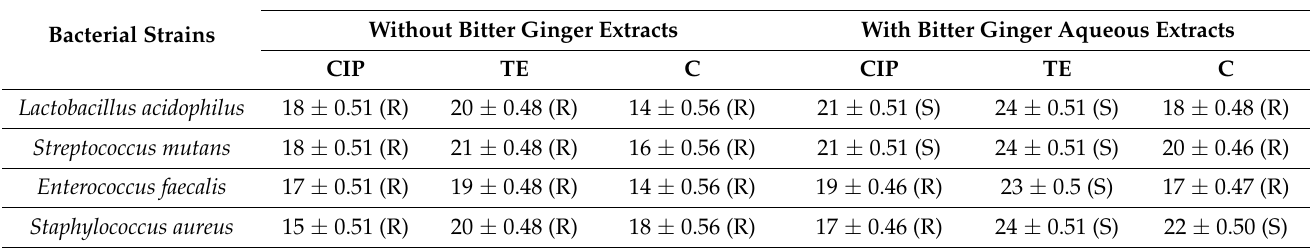
Table 4. Antibiotic susceptibility testing of the bacterial isolates with and without the bitter ginger aqueous extracts.